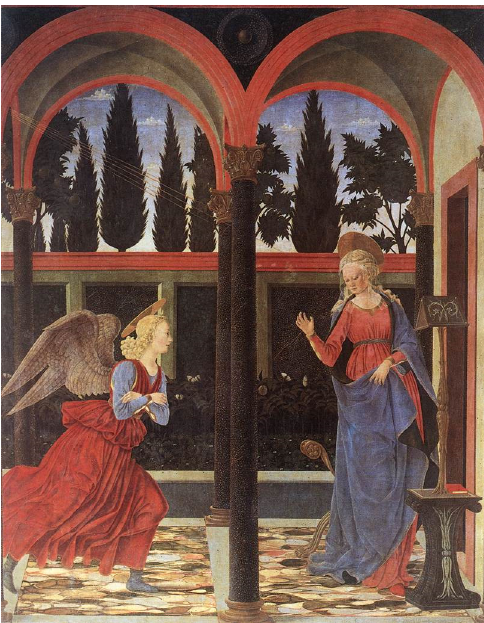
Figure 9. Alessio Baldovinetti, The Annunciation , c. 1457. Galleria degli Uffizi, Florence. Sandro Botticelli (1445–1510) shapes the Cestello Annunciation , 1489–1490, from the